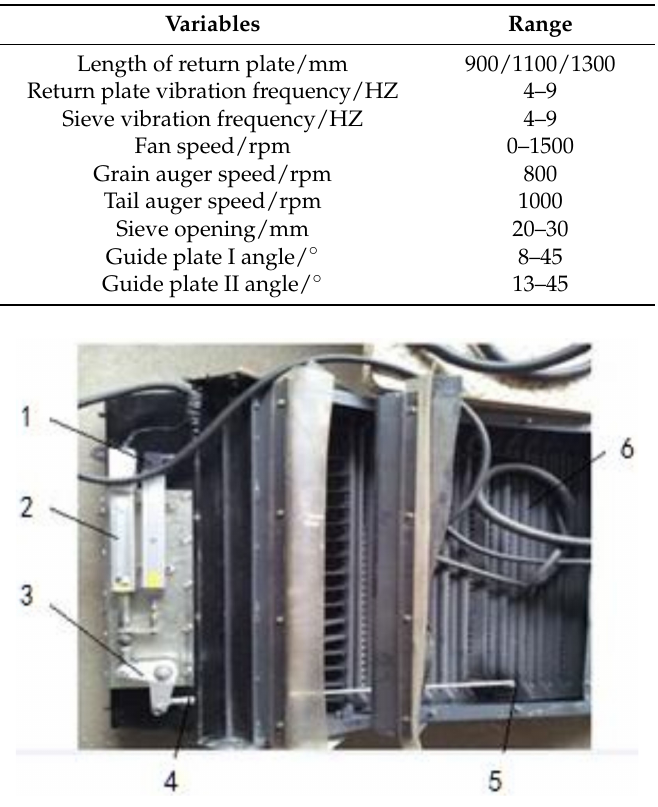
Table 1. Adjustment range of the working parameters.